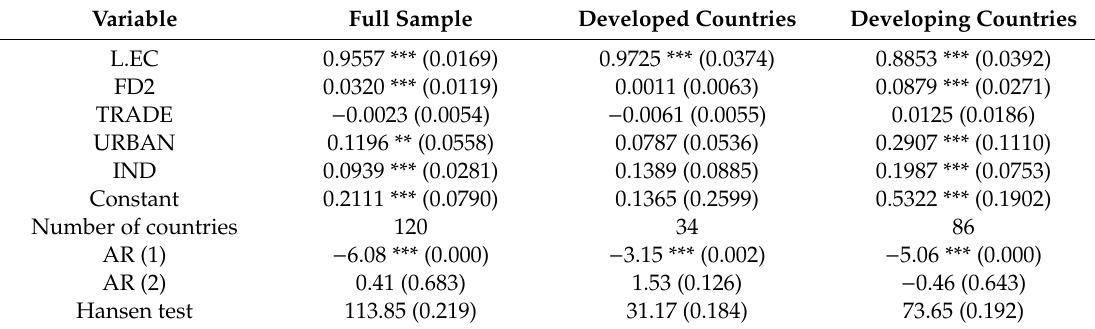
Table 9. Results of the full sample and sub-sample regressions with